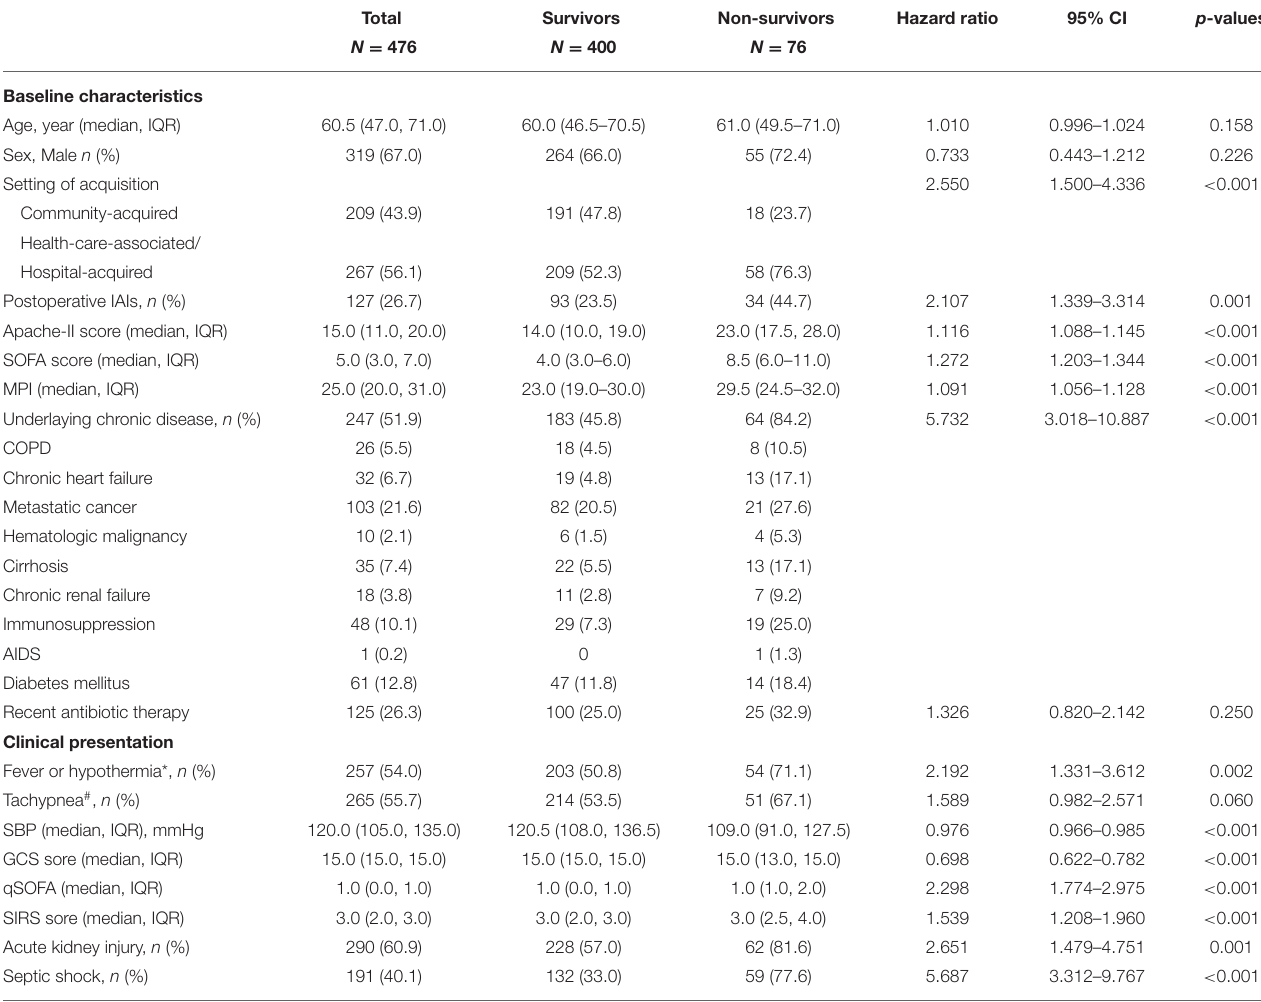
TABLE 1 | Demographic variables, setting of acquisition, baseline underlying condition, severity of condition, and clinical presentation of IAIs patients in